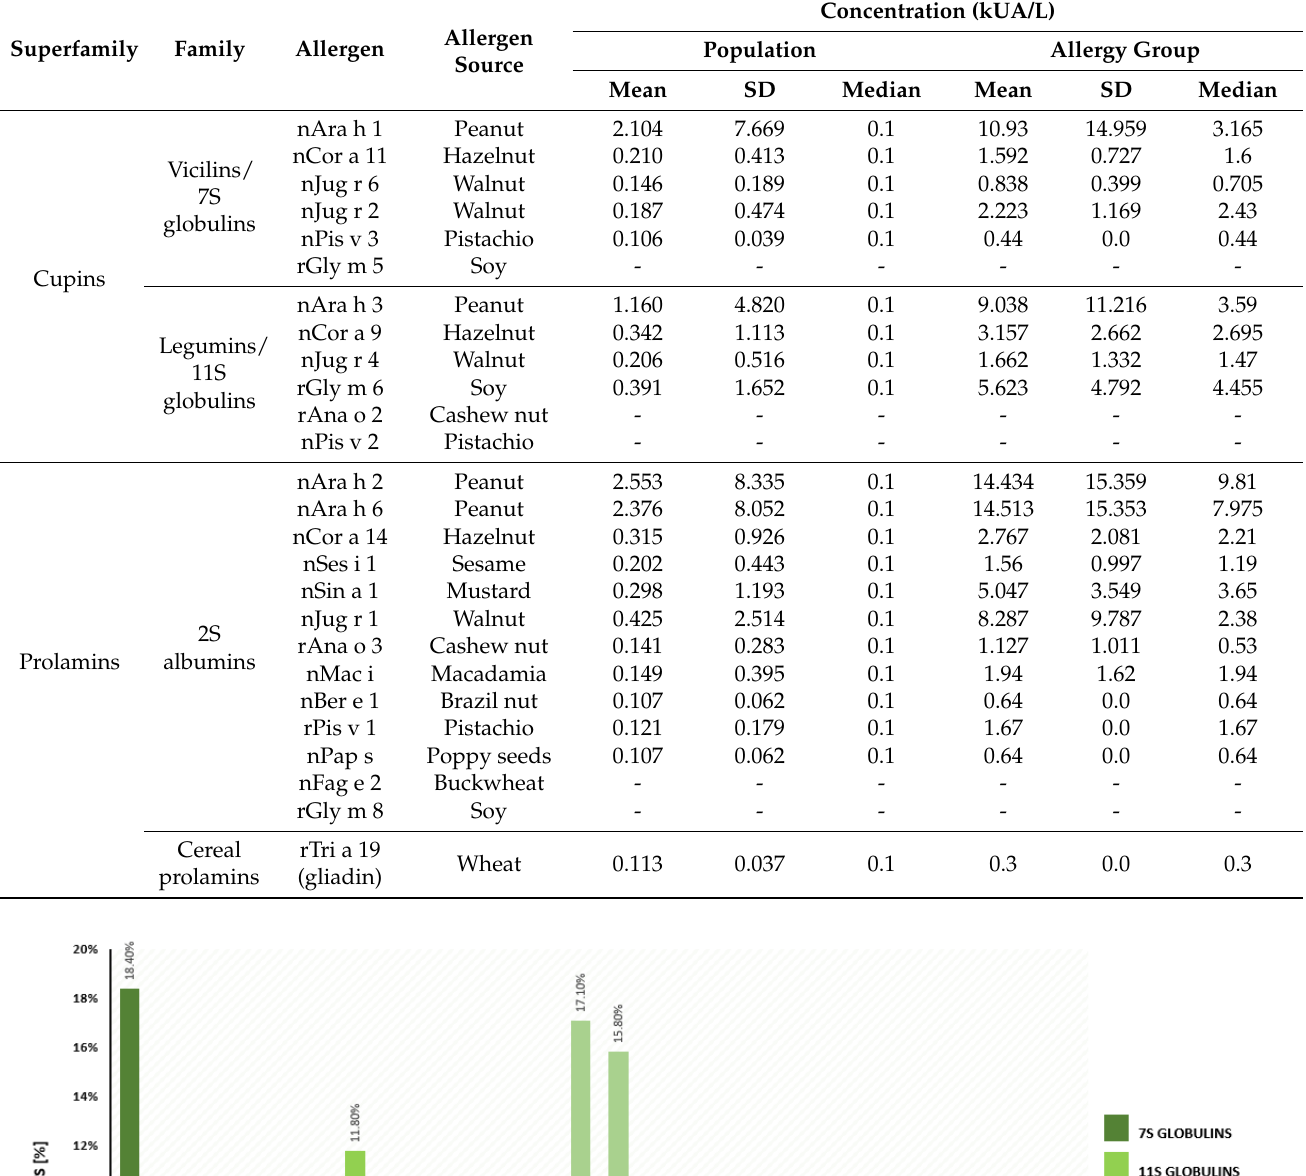
Table 1. Results of Allergy Explorer ALEX2.